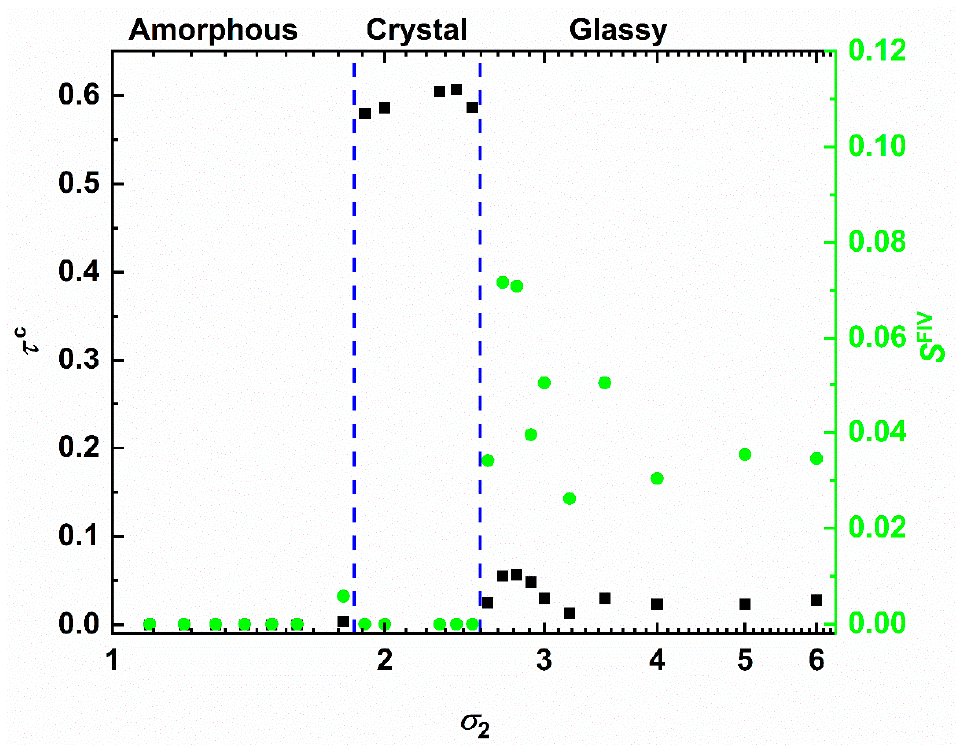
Figure 6. ( Left y -axis) Degree of crystallinity, τ c , ( = S HCP + S FCC ) and ( right y -axis) fivefold order parameter, S FIV , as a function of the interaction range, σ 2 , of the square well potential for a fixed intensity ( ε = 0.5) in log-linear scale. Vertical dashed, blue lines indicate the transition from amorphous to crystal and from crystal to fivefold-rich glassy regimes as dictated by the population of closed packed and fivefold sites and the corresponding established morphologies.